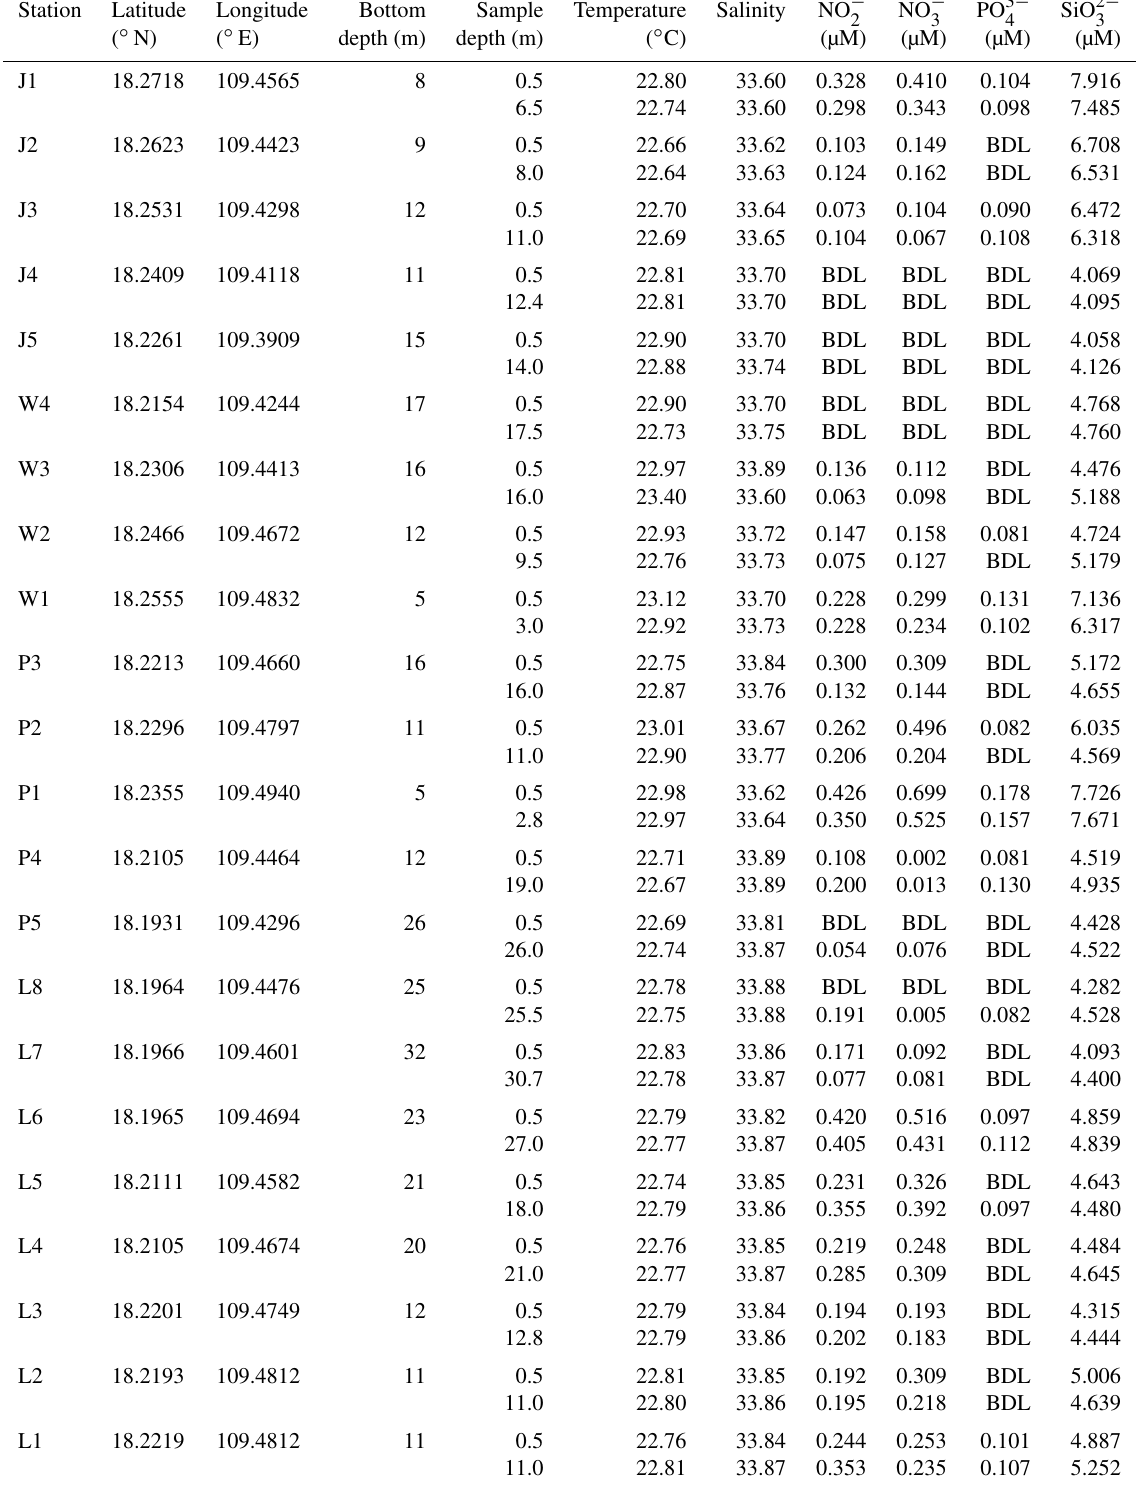
Table 1. Sampling stations and data collected in Sanya Bay in February